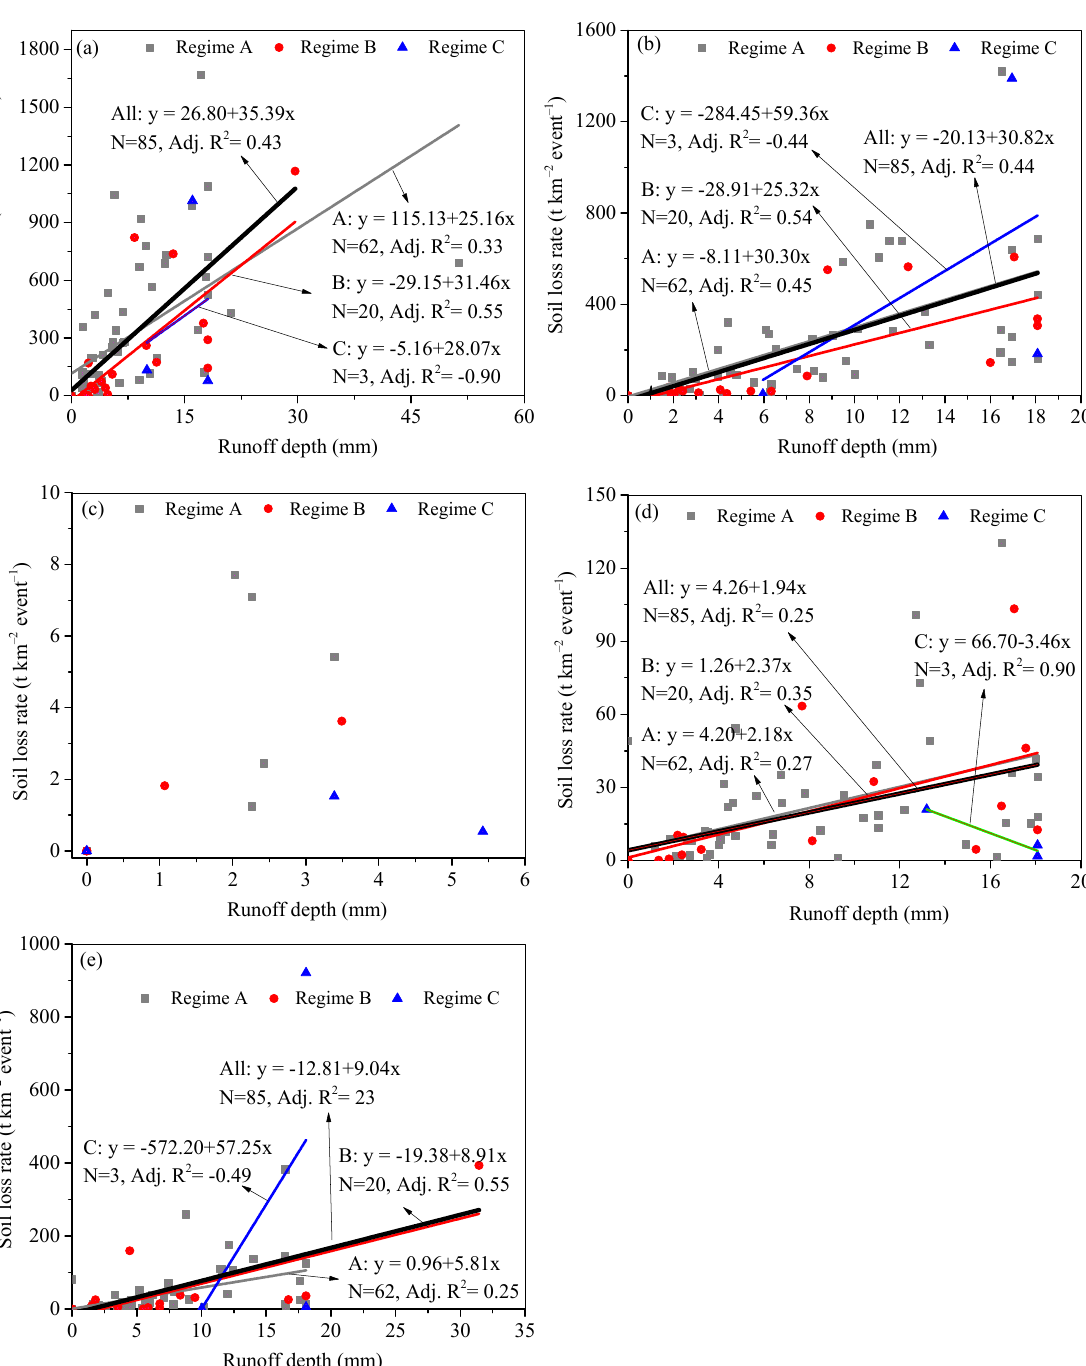
Figure 6. Relationships between the event runoff depth and event soil loss rate under different rainfall regimes for plot 1 ( a ), plot 2 ( b ), plot 3 ( c ), plot 4 ( d ), and plot 5 ( e ).